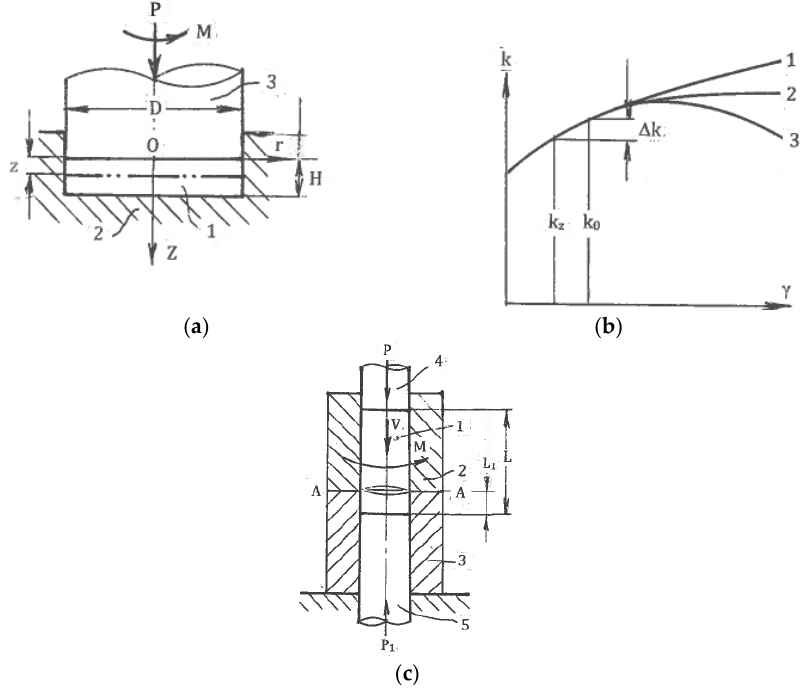
Figure 13. Schematic of high-pressure torsion (HPT): ( a ) fully constrained HPT; ( b ) hardening diagrams; ( c ) HPT of long samples.